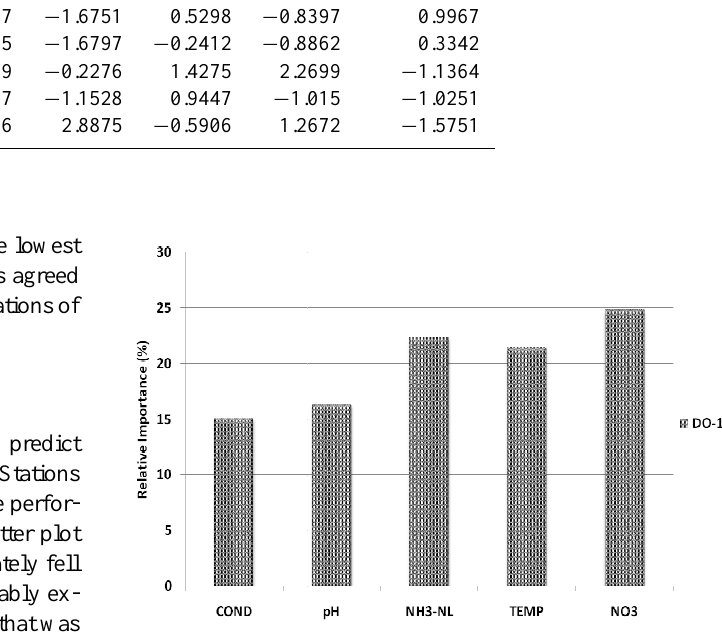
Fig. 10. The relative importance of each input parameter at Sta- Fig. 10: The relative importance of The relative importance of each input parameter at Station 1 each input parameter at Station 1 tion 1.